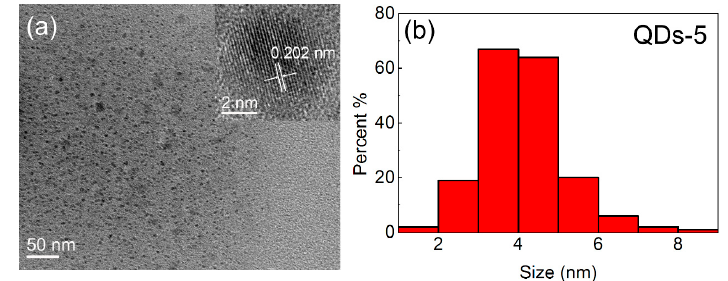
Figure A3. ( a ) TEM image and ( b ) particle size statistical chart of QDs-4.